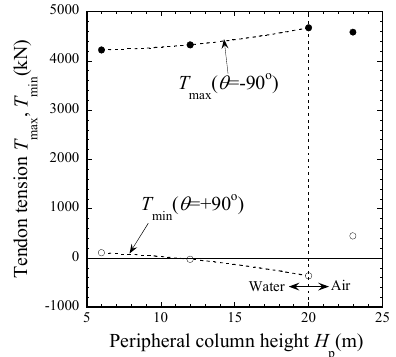
Fig. 8 Tendon tension dependency on D p ( L : H p = 30 m: 23 m, T 0 = 2290 kN, under storm conditions).